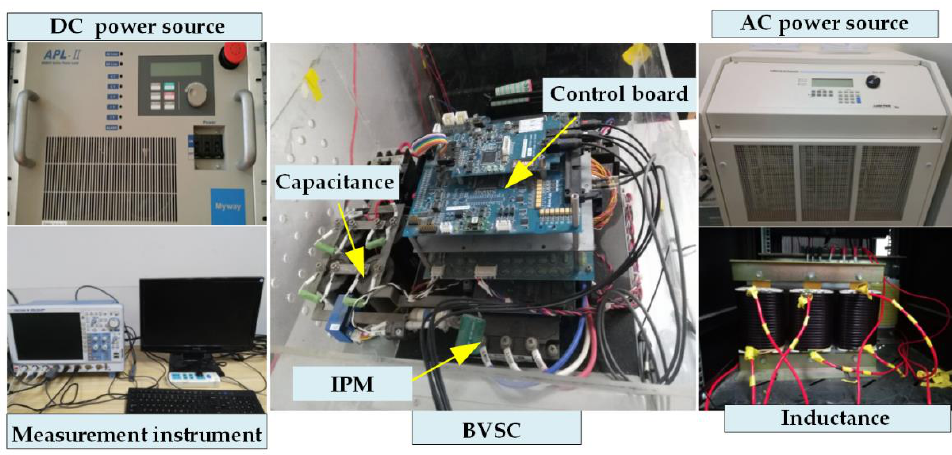
Figure 11. Experimental setup.